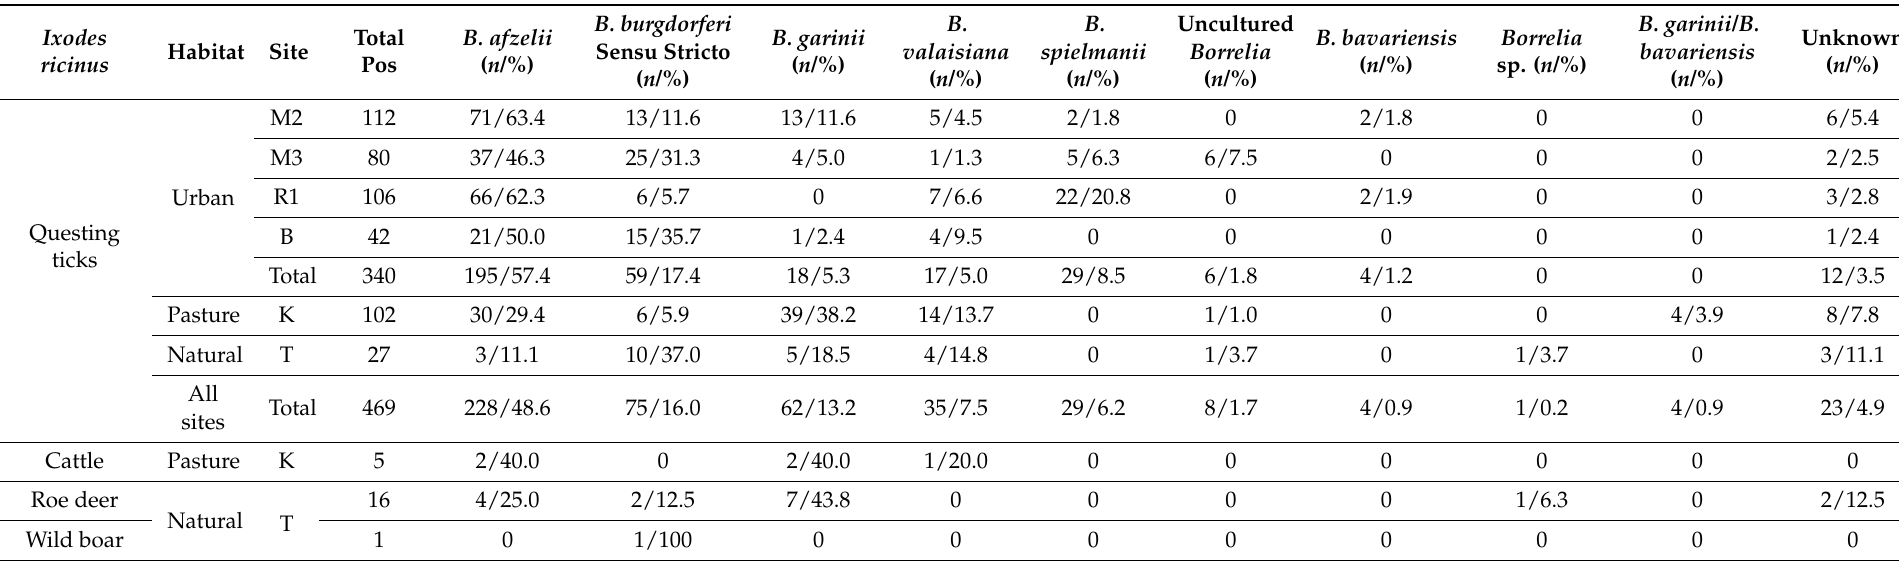
Table 2. Borrelia burgdorferi sensu lato species in questing and engorged Ixodes ricinus ticks per site and